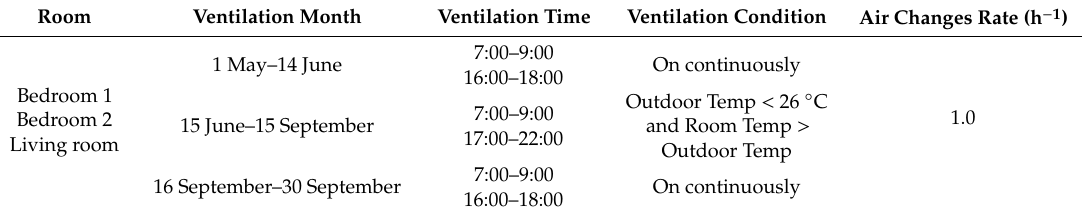
Table 8. Simulation parameters for natural